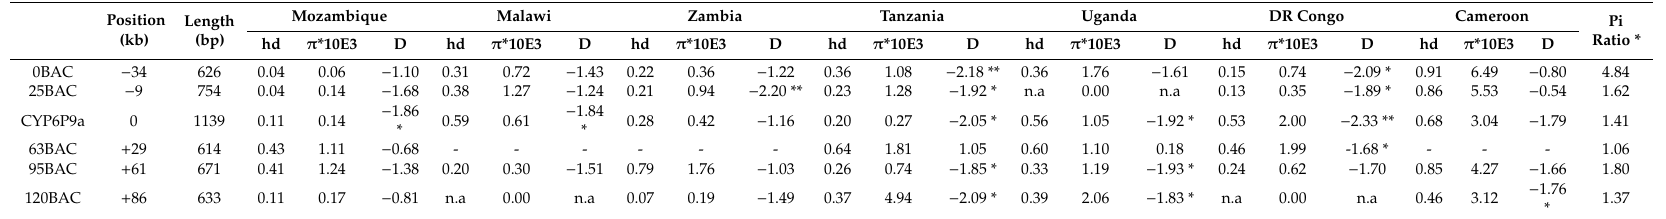
Table 3. Nucleotide diversity and neutral test at CYP6P9a and at 5 loci around it across